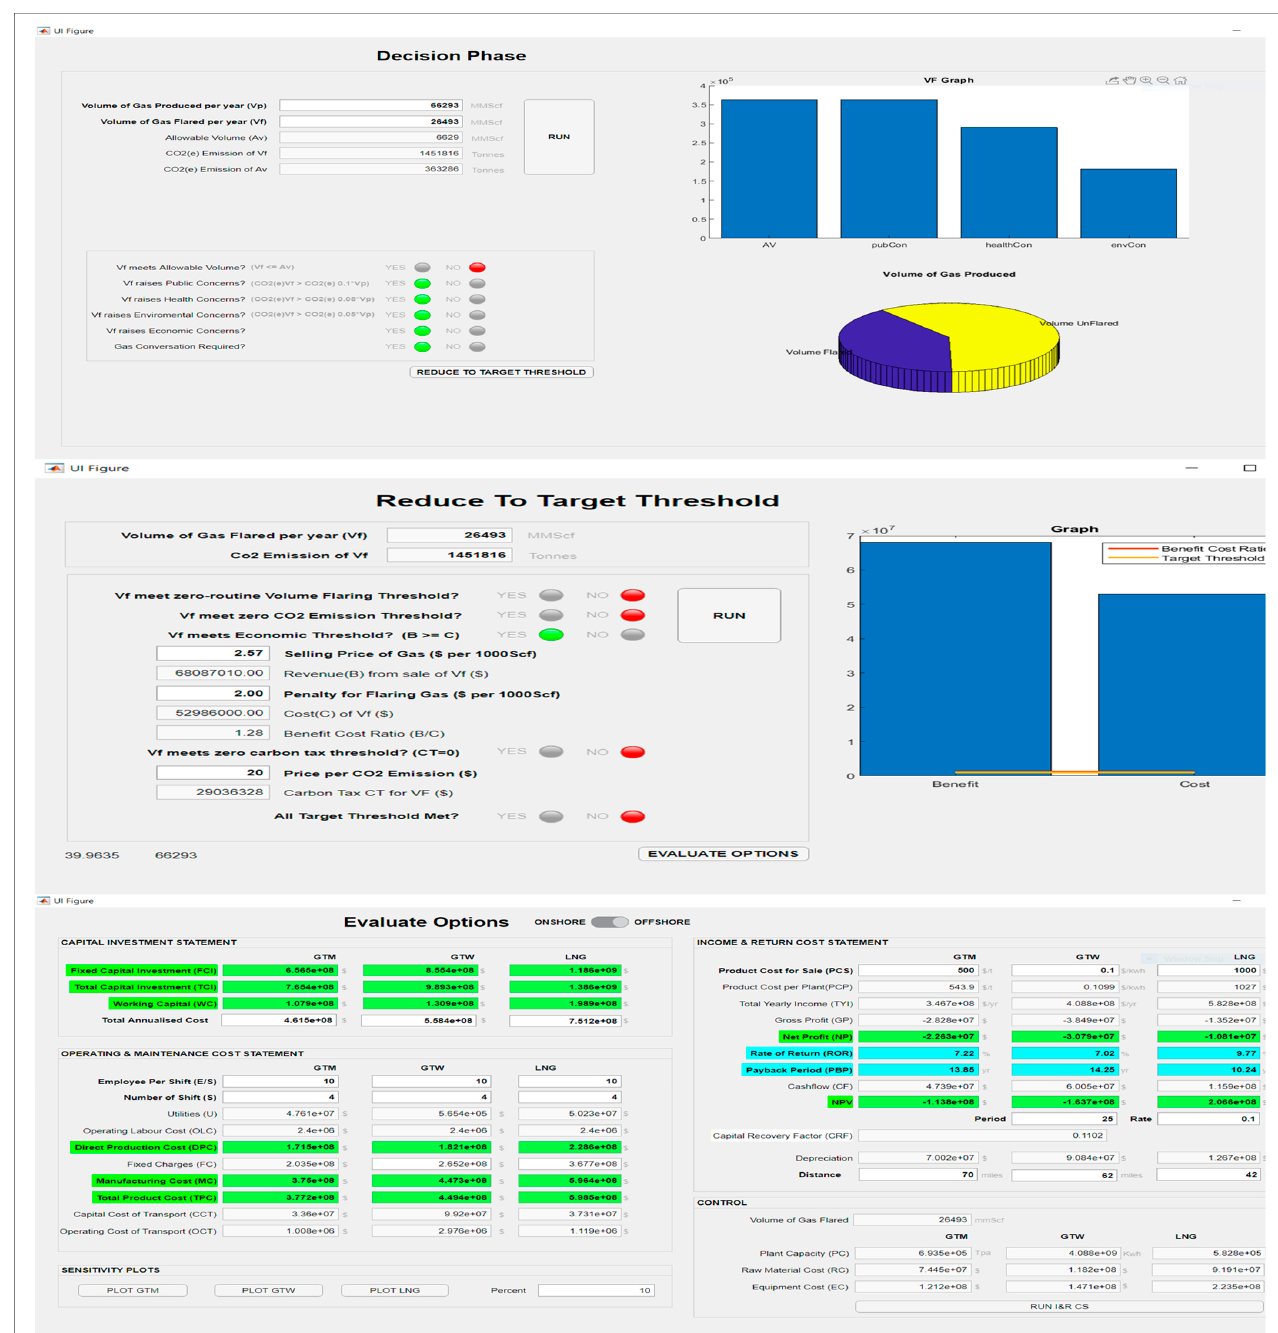
Figure 12. Decision Phase, Reduce to Target Threshold phase, and Evaluate Options phase for Field Y.